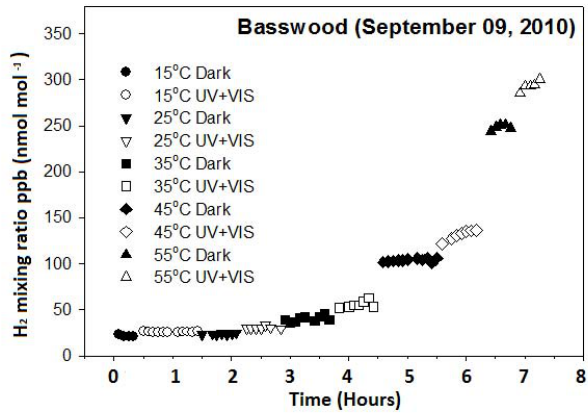
Fig. 1. Example of an analytical sequence exhibiting increasing H 2 concentrations with increasing temperature and light conditions (dark and UV + visible light). The automated GC system ran on a five minute sequence with analysis of a reference gas every 35min. Open symbols indicate stabilizing period and filled symbols indi- cate period used for averaging. Note the nearly instantaneous re- sponse of the plant material, in this case of Basswood, to changes in